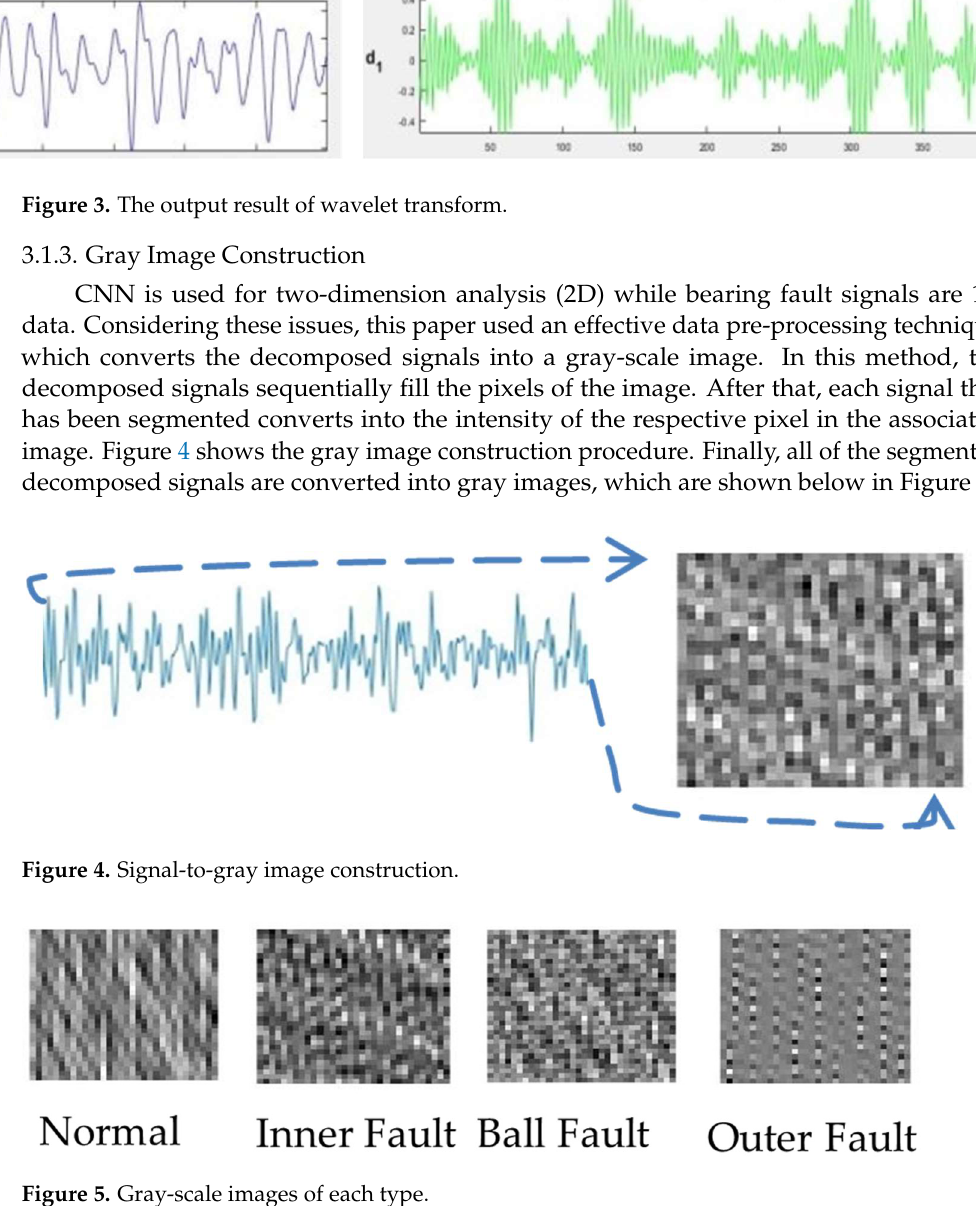
Figure 5. Gray-scale images of each